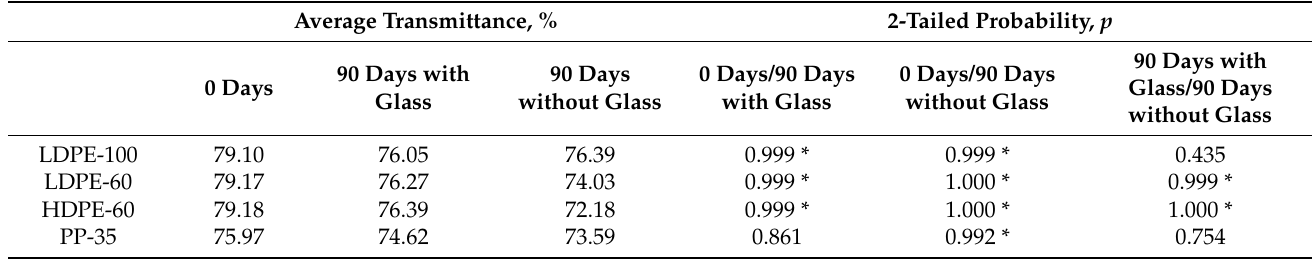
Table 3. Comparisons of average transmittances in the atmospheric